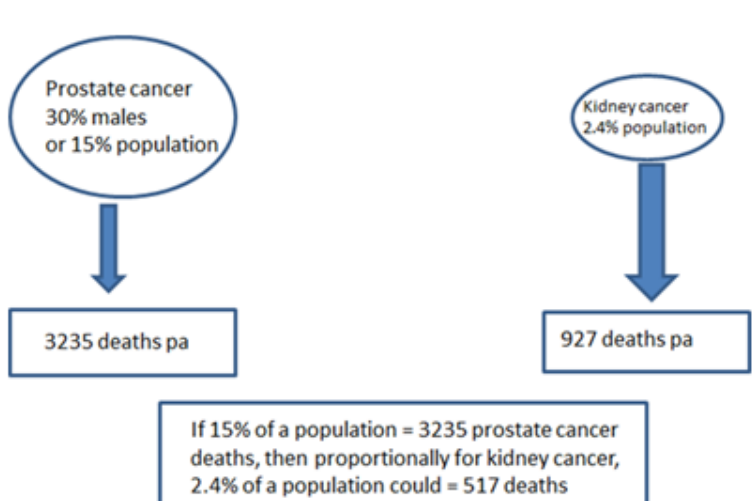
Figure 1. Comparison of incidence and deaths in prostate versus kidney cancer per annum in Australia in 2010. In 2010 there were 3,235 deaths from prostate cancer and 927 deaths from kidney cancer in Australia (1). The comparable incidence of the cancers is 30% of all males having prostate cancer diagnoses, versus kidney cancer at approximately 2.4% of a population. This indicates that kidney cancer deaths are almost double what could be expected by simply extrapolating from cancer incidence and prostate cancer